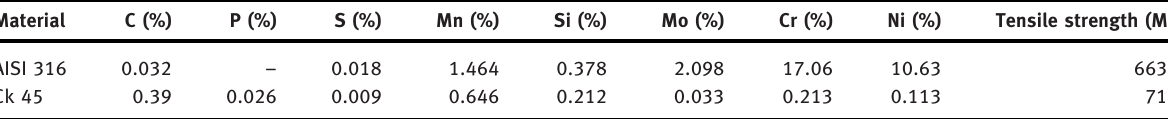
Table 1: The chemical composition of the materials used in the experiments (mass %).